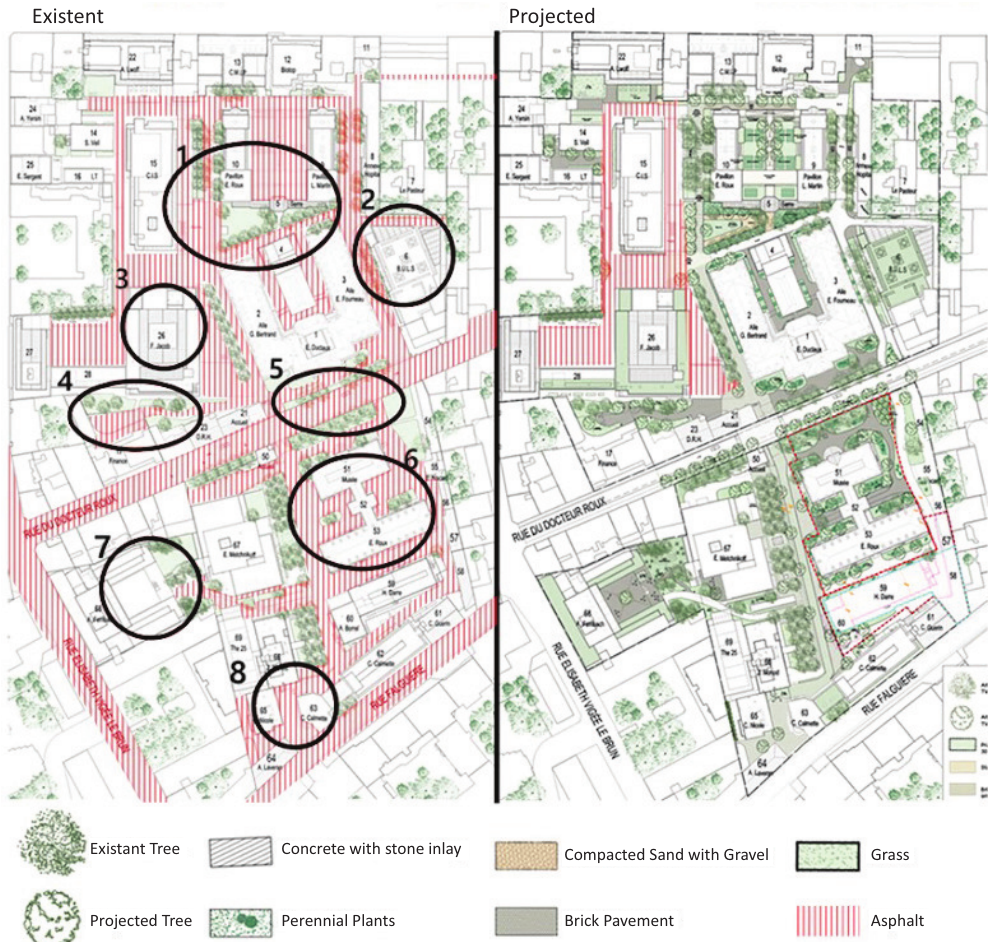
Figure 2. Comparison between the existing state of the chosen site and the intervention plan. Source: Courtesy of AIA Life